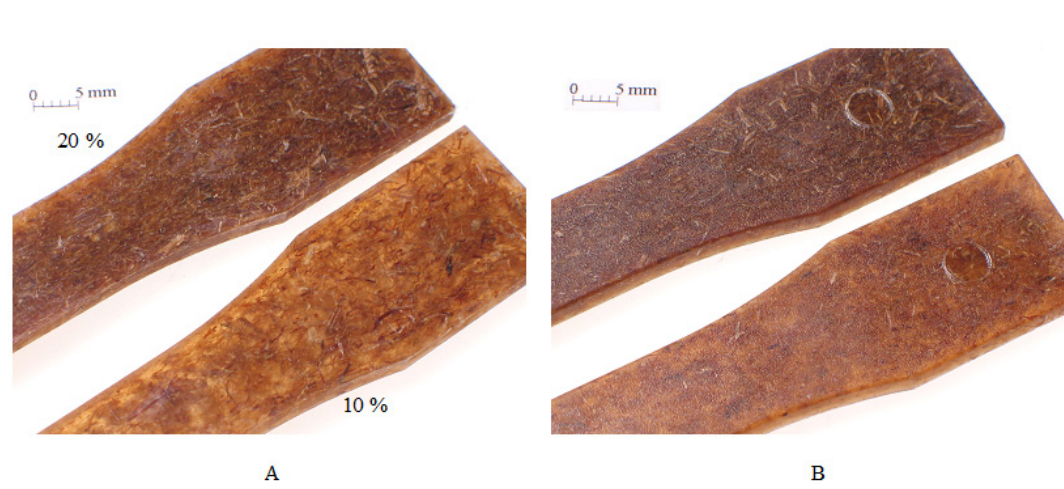
Fig 1. Polypropylene composites reinforced with pulp fibers (60 min) from biotreated bagasse obtained: a) tensile specimens of undecayed fibers/PP with 10 and 20 wt%; b) tensile specimens of biotreated fibers/PP with 10 and 20